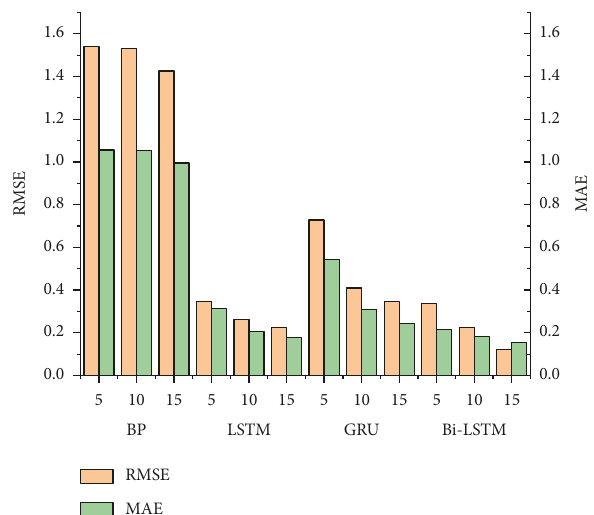
Figure 17: Comparison of prediction performance based on LSTM, GRU, and Bi-LSTM models.